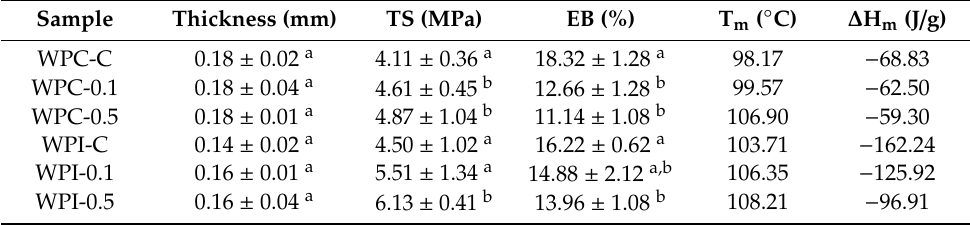
Table 2. Thickness, mechanical, and thermal characteristics of neat WPC / WPI and melanin-modified films.